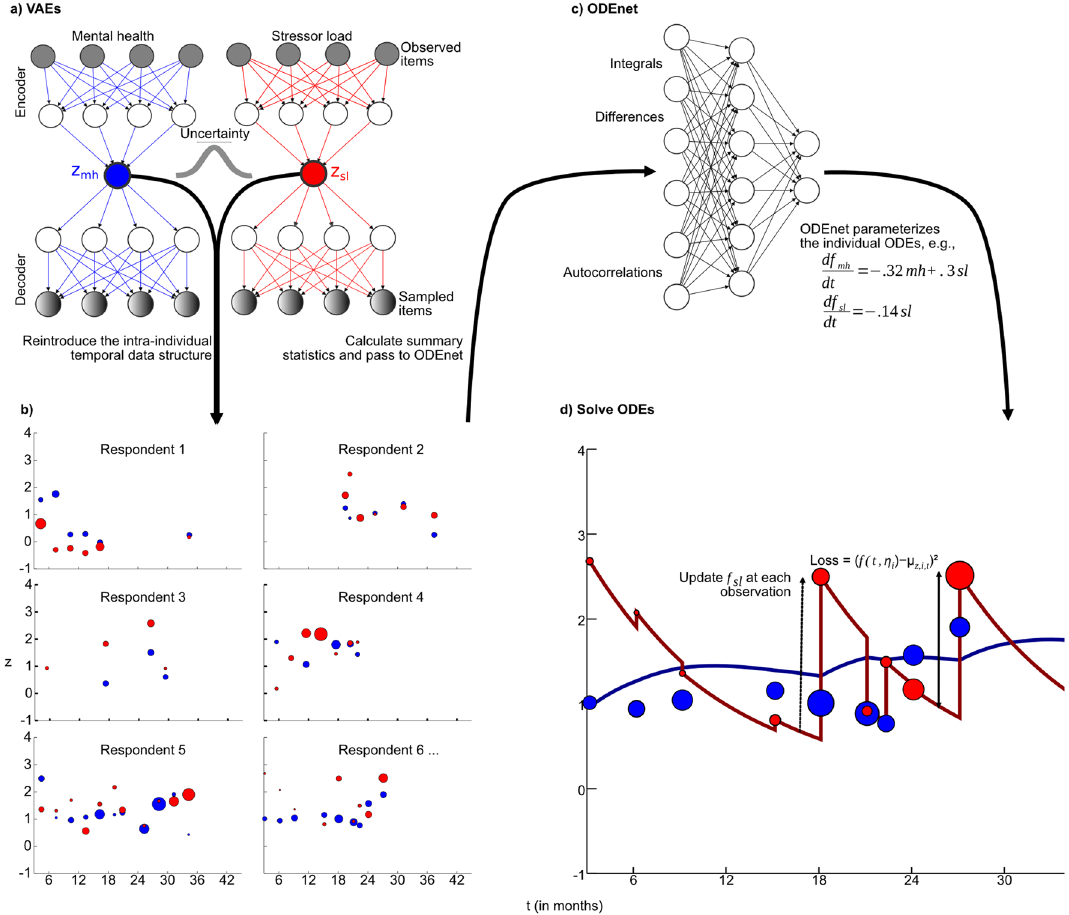
Figure 1. The proposed new method has two essential parts, dimensionality reduction and individualized trajectory estimation. Both tasks are performed using neural networks (upper row). We train two VAEs—one for mental health (blue) and one for stressor load (red)—to estimate the distribution in the latent space for each observation. The variance of these distributions is expressed as size of the dots and reflects uncertainty. Summary statistics of the temporal pattern of latent values are used as inputs to a feed-forward neural network (the “ODEnet”) which is trained to provide ODE parameters that minimize the squared distance of the ODE solution and the latent values, where latent stressor load values are updated at each measurement time